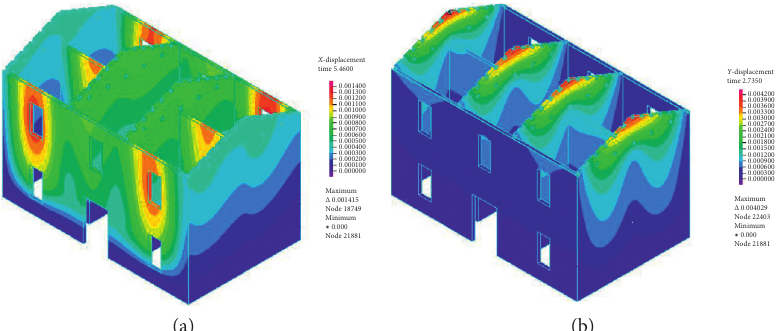
Figure 9: Cloud diagram of wall peak displacement under EL-Centro earthquake with 7-degree fortification intensity. (a) X -direction. (b) Y -direction.